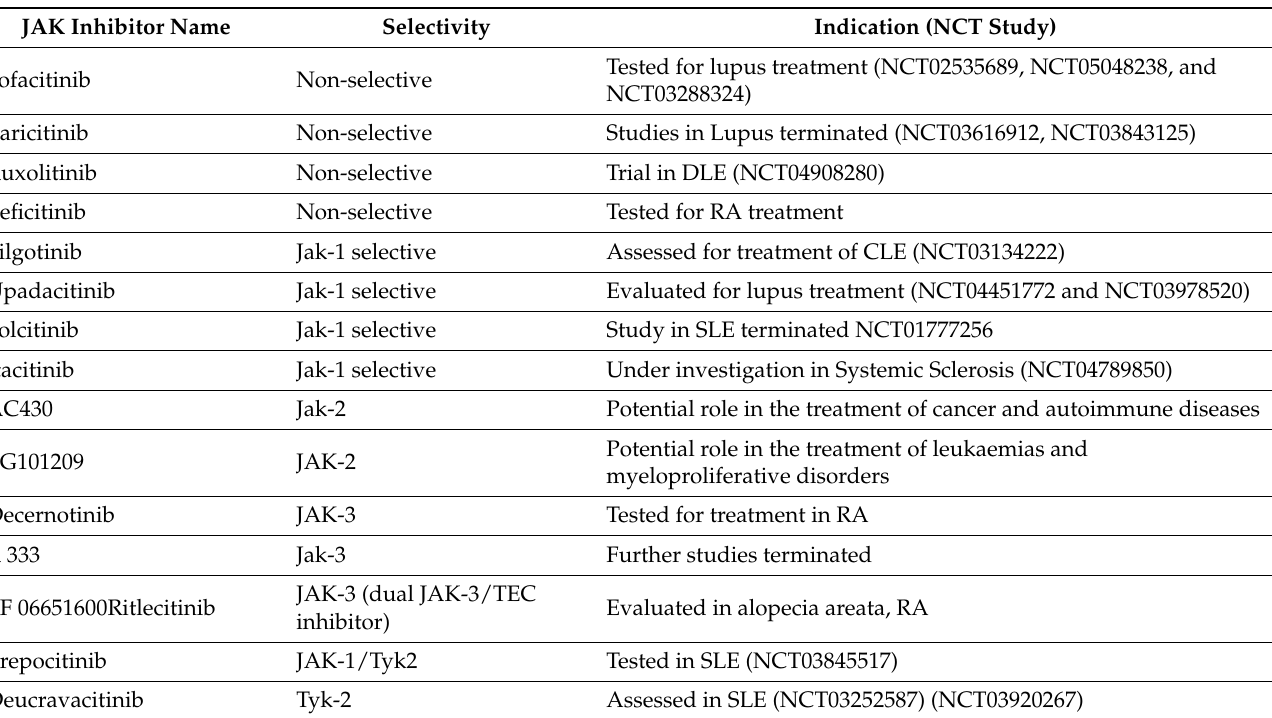
Table 1. List of Jakinibs with therapeutic potential in treatment of Systemic Lupus and Systemic